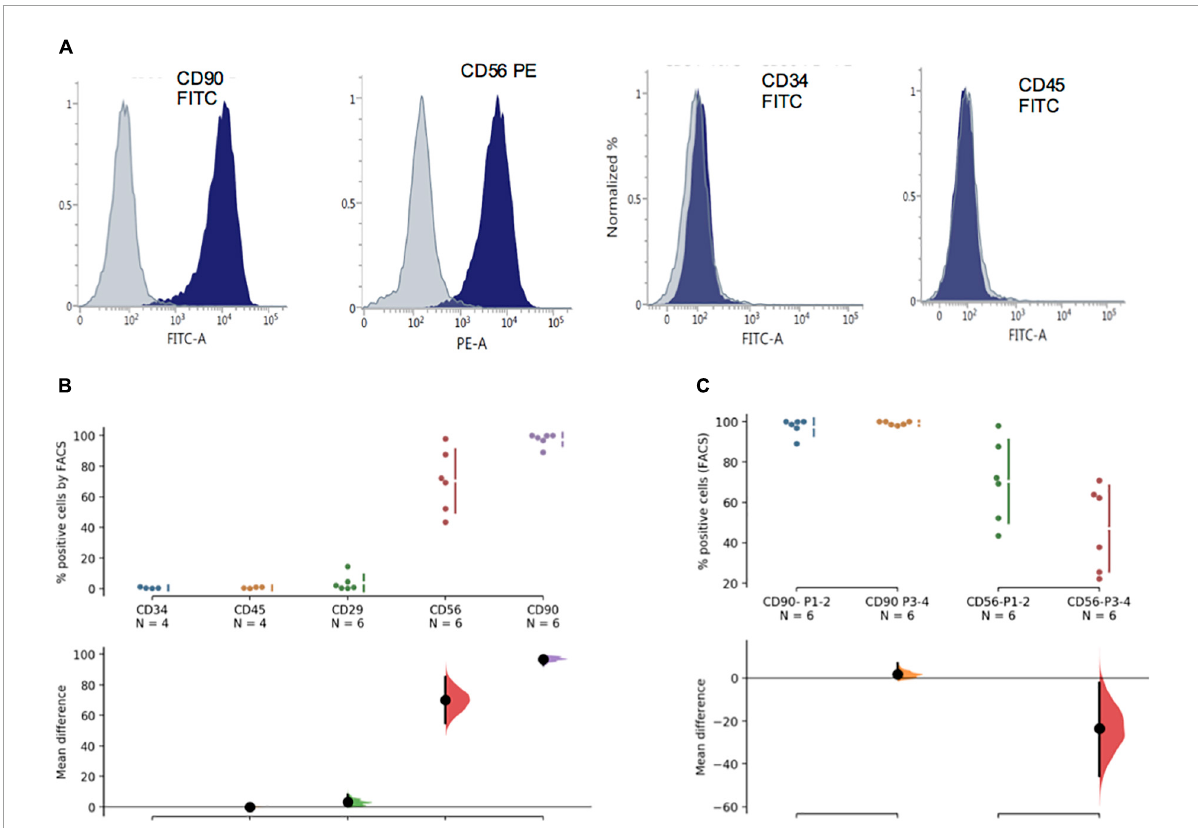
FIGURE3 PhDPSC analysis immunophenotyping by FACS shows predominant CD90 expression. (A) Top panel shows representative FACS histograms for each of the markers tested including hematopoetic markers CD 34 and CD45, mesenchymal markers CD29 and CD90 as well as neural crest marker CD56. Gray plot shows negative control and blue plot shows positive population. (B) Quantitative analysis by FACS is depicted as percentage positive cells and shows negligible expression of CD34 and CD45, slightly higher percentage of cells express CD29 with significantly higher percentage expressing CD 56 and CD 90. The analysis depicts pooled data from experiments performed on 2-3 different cell lines from passage 1-2. CD34 expression is used as the standard against which remaining samples are compared. (C) CD90 and CD56 percentage positive cells in primary DPSC is depicted over time in culture. Despite repeat passaging, percentage of CD90 cells remain high and stable in the phDPSC population. A trend toward decline in percentage of CD56 cells with passage is seen although the mean difference between early and later passages is not significant. CD 56 expression at each passage also shows significant variability (as seen by the spread of the individual data points). This analysis was performed on cells from 3 different cell lines comparing expression in P1-2 with P3-4. In (B,C) , raw data and spread is shown as a Cumming estimation plot on the upper axes and mean difference compared to control sample (In B, CD34 data is used as control) are plotted as bootstrap sampling distributions on the lower axes. Each mean difference is depicted as a dot and each 95% confidence interval is indicated by the ends of the vertical error